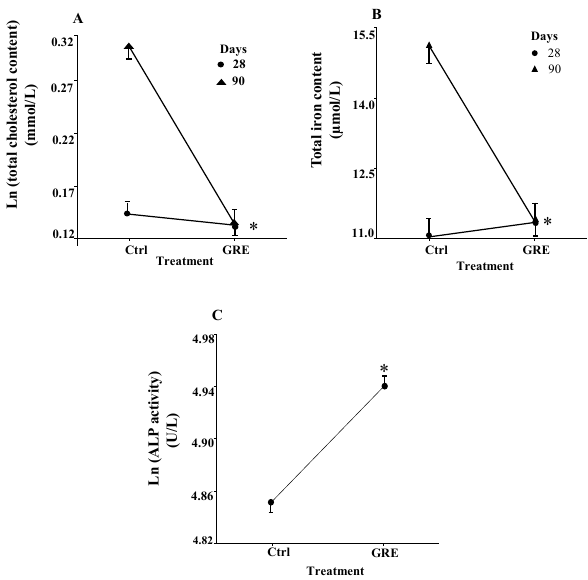
Figure 1. Modulation of serum clinical biochemical parameters of male Fischer rats by GRE following B a dietary treatment of 28 ( n = 10 per group) and 90 days ( n = 10 per group), respectively. ( A ) Interactive effects of GRE on Chol levels after 28 and 90 days; ( B ) interactive effect of GRE on Fe levels after 28 and 90 days; and ( C ) GRE main effect on ALP. Plots of Chol and ALP derived from log transformed data (means ˘ standard error). * GRE differs significantly when compared to the 90 day control treatment ( p < 0.05 for ( A ); p < 0.001 for ( C )); GRE differs significantly ( p < 0.05) from the control (main effect—( C )). Abbreviations : Chol, total cholesterol; ALP, alkaline phosphatase; serum Fe, total